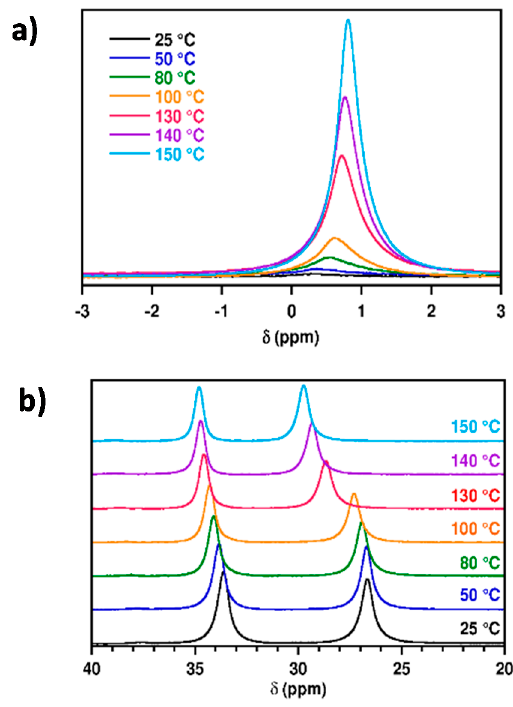
Figure 2. 7 Li NMR ( a ) and 31 P NMR ( b ) of electrolyte [TMP] ([P66614][TMP] + 0.2 M LiTMP) at different temperatures.